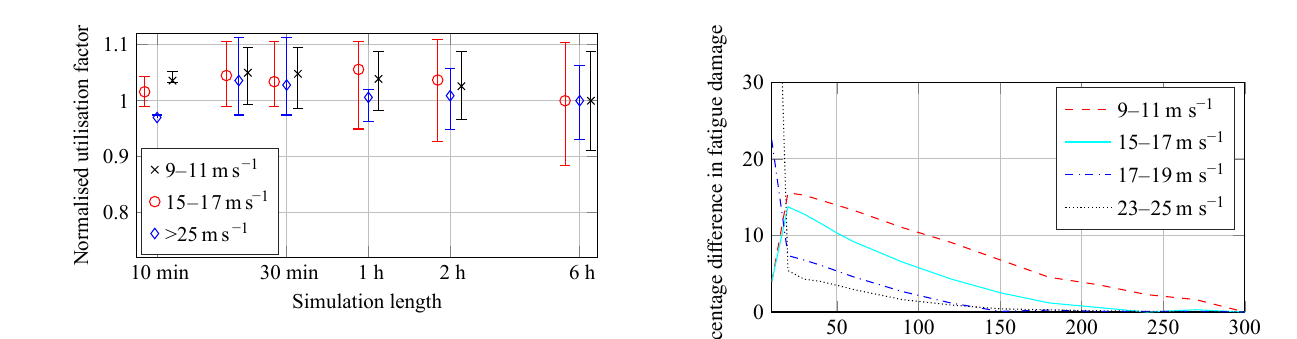
Figure 13. Normalised mean ULS utilisation factor for increasing simulation lengths (constant overall length of 500 × 10min, leading to 500 to 14 simulations) and different wind speeds. Figure 14. Initial transient behaviour of the operating wind turbine